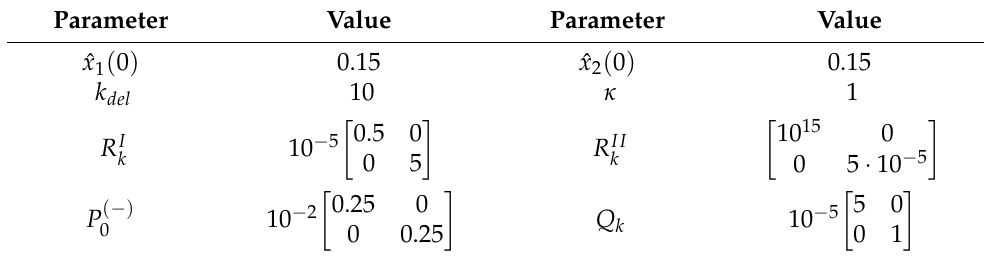
Table 2. Parameters and initial conditions for exothermic reactor scenario I.